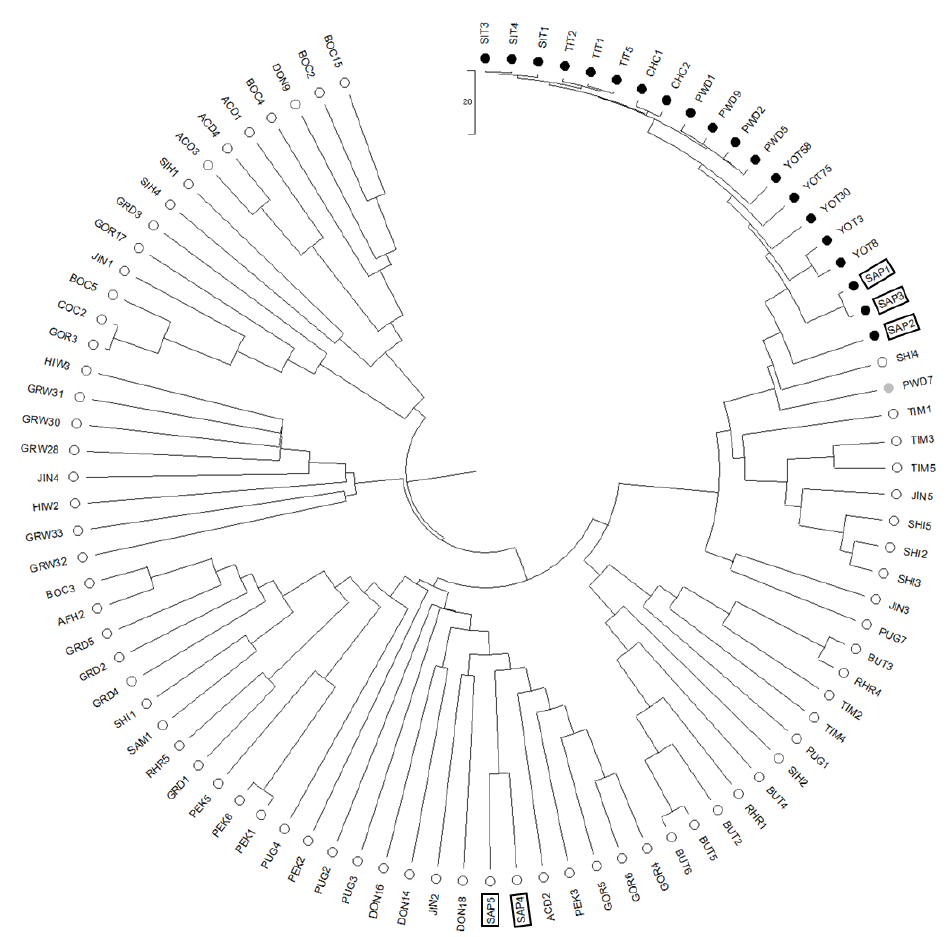
Figure 4. A phylogenetic tree for the 200 kb region on dog chromosome 13 with selection sweep for the hair length phenotype. A UPGMA phylogenetic tree was constructed using 785 SNPs from a total of 92 dogs belonging to 24 breeds with various hair length phenotypes. The branch length was determined on the basis of pairwise nucleotide differences in the CFA13:8,530,000 − 8,730,000 bp region among individuals. Homozygotes for the RSPO2 3’ UTR insertion are indicated by closed circles, and animals without the insertion are indicated by open circles. Gray circles indicate heterozygotes. Five Sapsarees were additionally marked with black squares. GOR (Golden Retriever), ACD (Australian Cattle Dog), AFH (Afghan Hound), YOT (Yorkshire Terrier), BOC (Border Collie), BUT (Bull Terrier), GRD